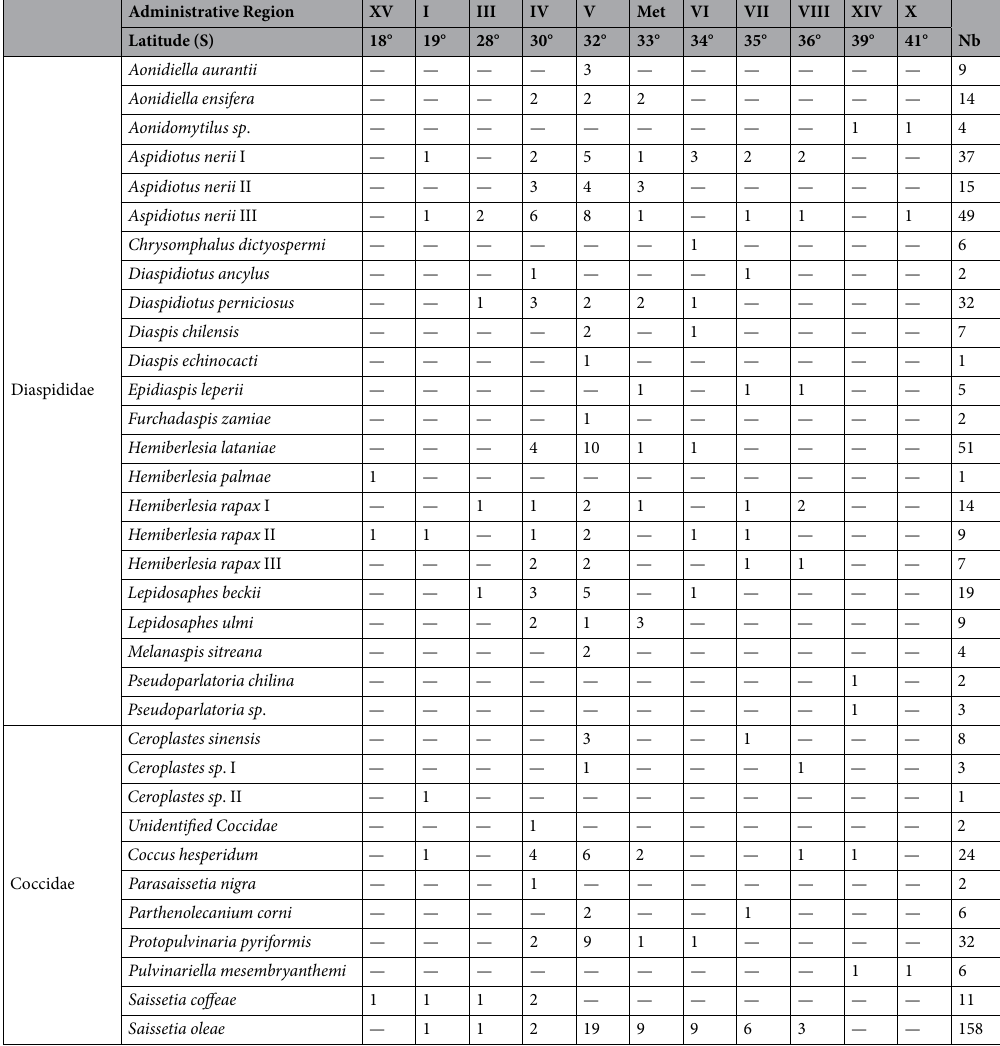
Table 1. List, by family and alphabetical order, of the 21 species of Diaspididae and 13 species of Coccidae surveyed, their distribution (from North to South) and the number of individuals sequenced (Nb). The values in the table indicate the number of sites sampled per region. The minimum distance between sites was at least 1 km. Latitudes correspond to the median coordinate of each administrative